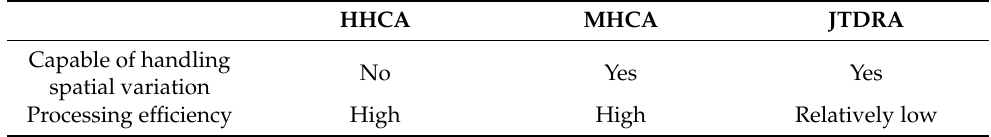
Table 1. Comparison between the related